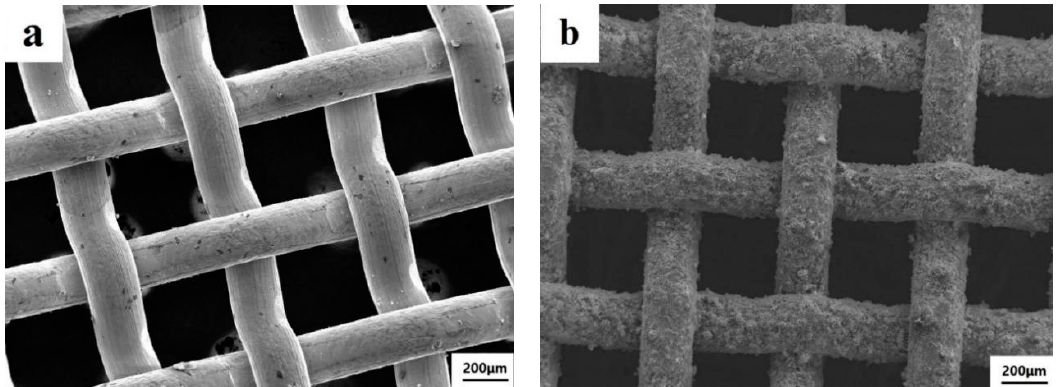
Figure 9. The morphology of wire-mesh before ( a ) and after ( b ) spraying.